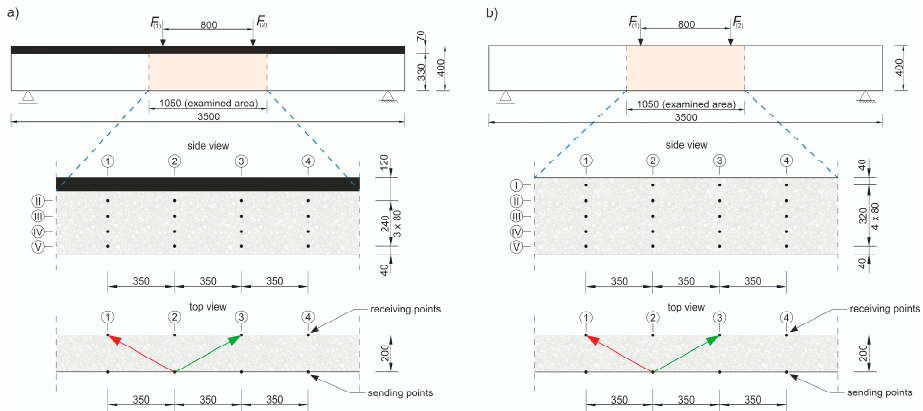
Figure 14. The areas of the beams for which the ultrasonic tests were carried out, with the scheme of the distribution of the sending and receiving points (Roman numerals indicate the rows of the points in horizontal planes, and Arabic numerals indicate the numbers of the successive points in given rows; dimensions are given in mm): ( a ) beam #2, ( b ) beam #3.